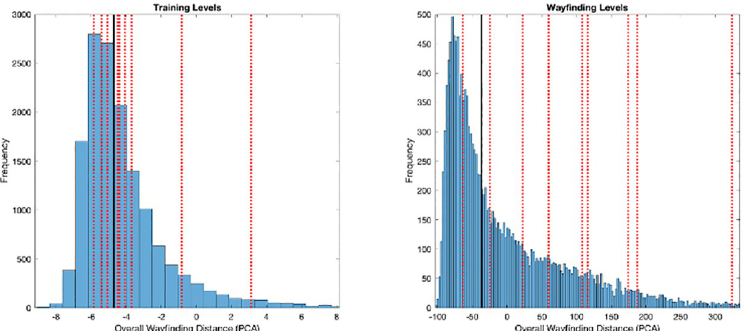
Fig 3. Summary histogram of control group and TBI group distance performance on training and wayfinding levels plotted against population data.